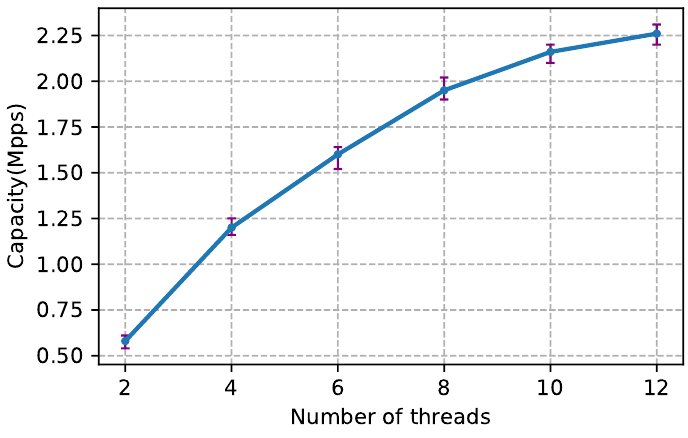
Figure 6. EVA’s scalability with the number of